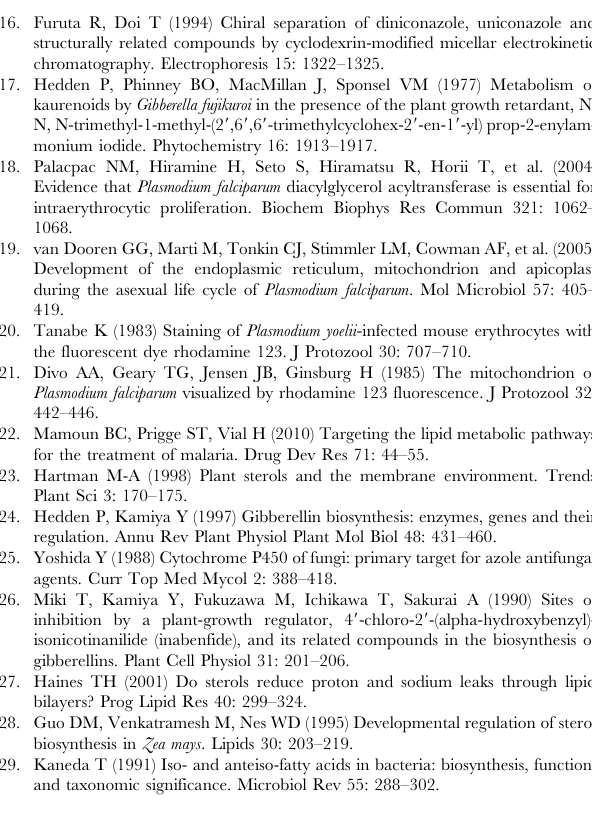
were washed with RPMI 1640 twice and mixed with P. falciparum infected erythrocytes at 0.3% starting parasitemia. Thin blood films from each culture were prepared after 48 h, stained with Giemsa and parasitemias were counted under a microscope. Values are mean 6 SD of n = 3 in each representative experiment. Figure S5 Influence of INA concentration on growth inhibition in P. falciparum . (A) Synchronized parasites at early trophozoite stage were treated with 0 (1 m l/ml DMSO), 10 or 50 m M INA for 0–8 h. Parasitemia was determined by thin blood films after staining with Giemsa. Error bars represent the standard deviation (SD) of three independent experiments made in duplicate. Data are normalized relative to those for the control treated for 0 h. (B) The parasites treated with 0, 10 or 50 m M INA after 4 h, stained with Giemsa, and visualized under light microscope. Scale bar= 3 m m. Each panel shows the typical morphology of trophozoite-stage parasites in each treatment. Figure S6 Effects of cation species to the parasitemia of the intraerythrocytic parasites treated with INA. Syn- chronized parasites at early trophozoite stage were mixed with 10% of 1 6 and 4 6 normal PBS or the solution that Na + and K + concentrations in PBS are exchanged (reversed-PBS; 1 6 reversed- PBS contains 137 mM KCl, 8.1 mM K 2 HPO 4 , 2.68 mM NaCl, 1.47 mM NaH 2 PO 4 ), and treated with 50 m M INA or 1 m l/ml DMSO for 8 h. Parasitemia was determined by counting thin blood film from each culture blindly after staining with Giemsa;